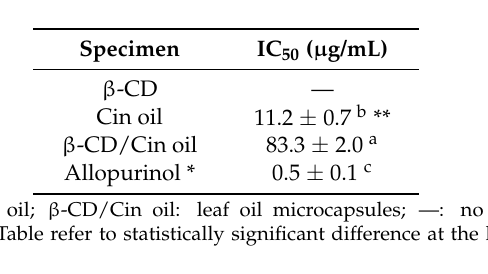
(Table 3). Xanthine oxidase inhibitory activity of C. osmophloeum leaf oil increased with the content of trans -cinnamaldehyde in leaf oil. Table 3. Xanthine oxidase inhibitory activity of leaf oil and leaf oil microcapsules. Table 3. Xanthine oxidase inhibitory activity of leaf oil and leaf oil